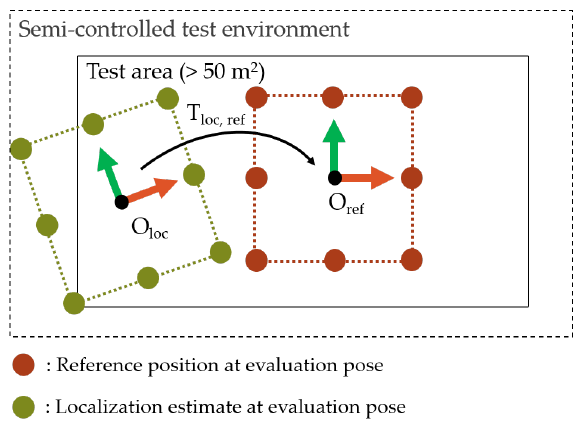
Figure 8. Determination of the transformation matrix T ref , loc between O loc and O ref with the Umeyama alignment [48].